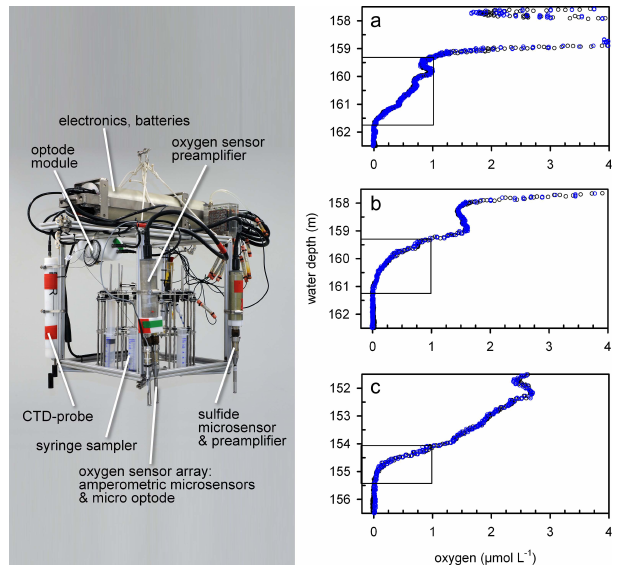
Fig. 5. Left-hand panel: sampling platform “PIA” for the high- resolution measurement of nanomolar oxygen concentrations. Right-hand panel: three examples of high-resolution oxygen pro- files measured within 3h on 7 July 2010 in the south basin of Lake Zug, Switzerland. Oxygen concentrations were derived in paral- lel from a microoptode (blue) and an amperometric microsensor (black, after in situ recalibration based on optode data). Boxes indi- cate sub-micromolar oxygen